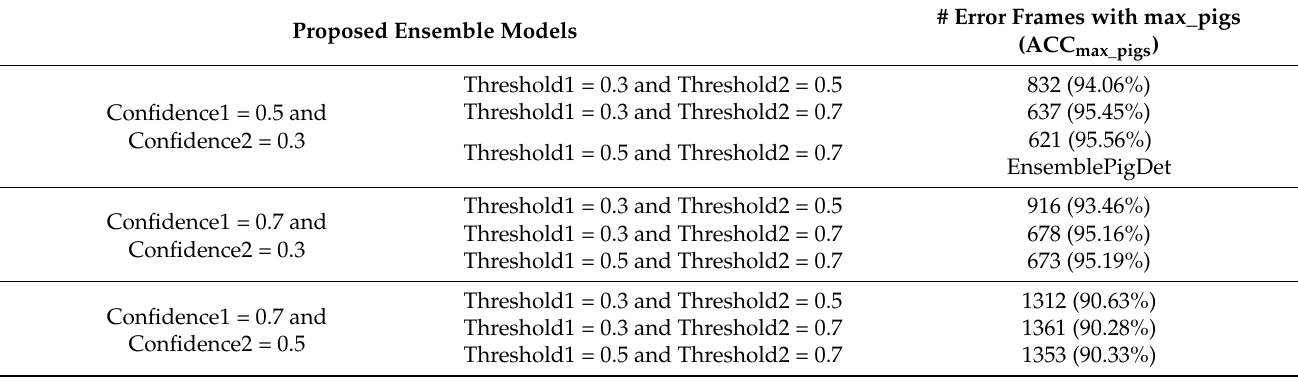
Table 8. Comparison of accuracy ACC max_pigs for 13,997 key frames with overexposed regions (obtained during 8:30 a.m. to 10:30 a.m.) with different ensemble parameters (case of Confidence1 and Threshold1 = aggressive, Confidence2 and Threshold2 = conservative). Proposed Ensemble